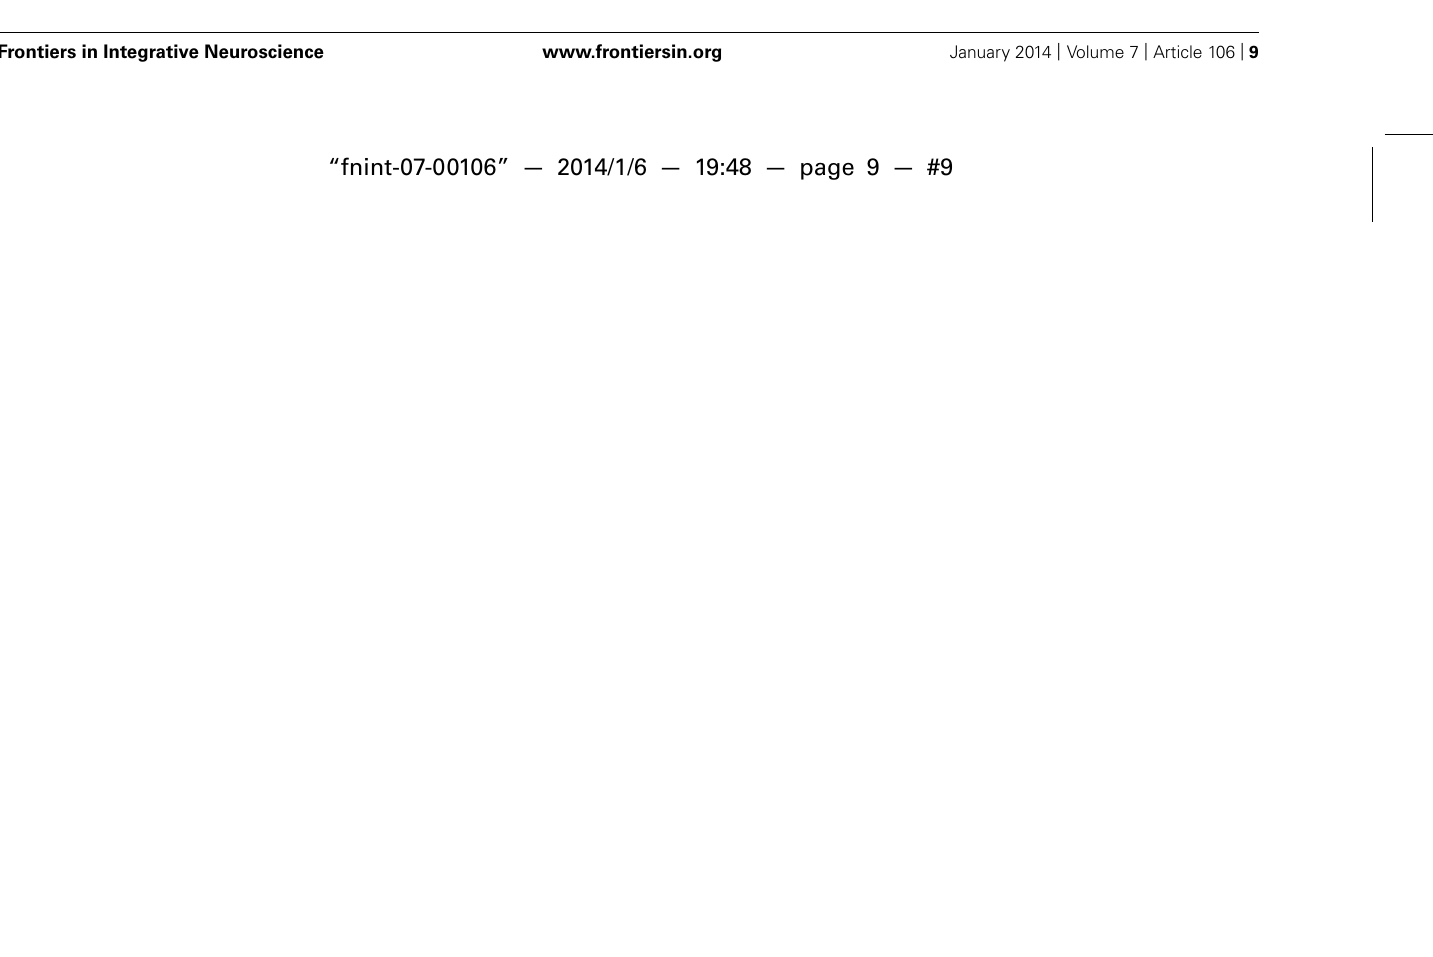
cocaine-treated rats. (E–R) Representative microphotographs showing low- and high-magnification (insets) views of astroglial cells in the striatum and hippocampus.The histogram displays the means ± the SEMs ( n = 8/group) of the numbers of GFAP-ir cells per area (mm 2 ) and GFAP immunoreactivities (arbitrary units). One-way ANOVA: ∗ P < 0.05, ∗∗ P < 0.01, ∗∗∗ P < 0.001 vs. vehicle group; $ P < 0.05, $$ P < 0.01, $$$ P < 0.001 vs. repeated cocaine group; & P < 0.05, && P < 0.01 vs. AM630 group; ## P < 0.01, ### P < 0.001 vs. Rimonabant group. Scale bars are included in each